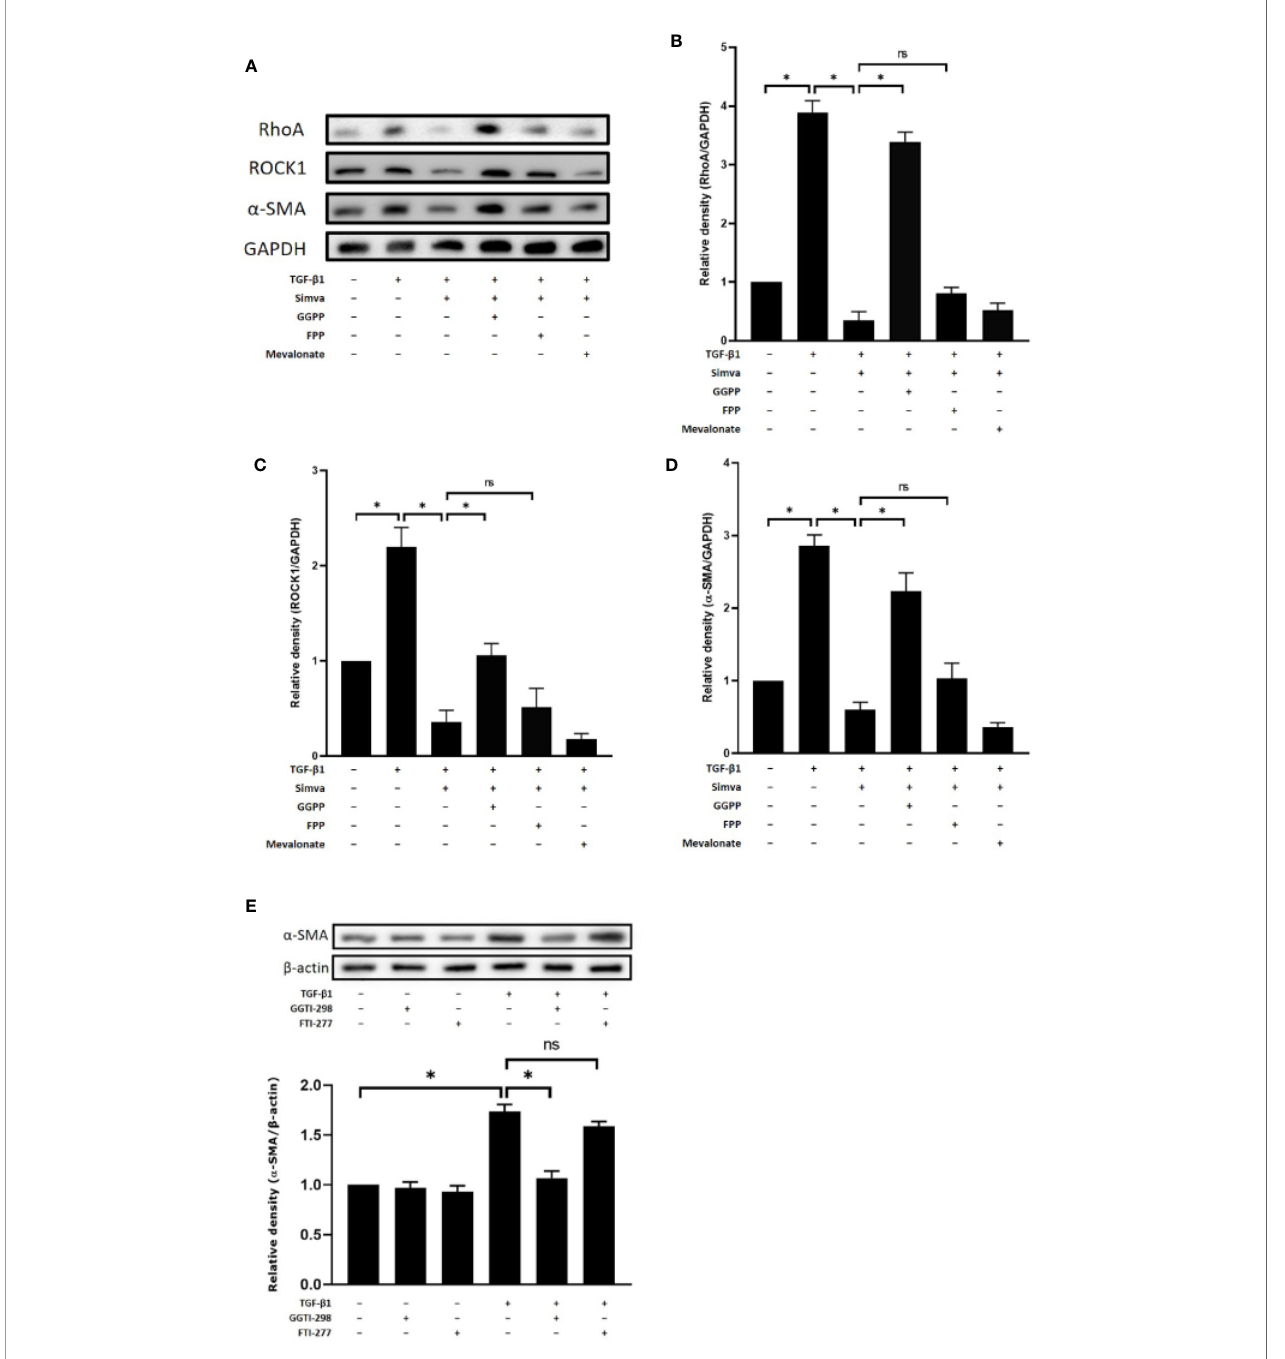
FIGURE 3 | Effects of hydroxymethylglutaryl-coenzyme A (HMG-CoA) downstream intermediates on simvastatin-mediated inhibition of transforming growth factor- b (TGF- b )-induced RhoA, Rho-associated protein kinase 1 (ROCK1), and a -smooth muscle actin ( a -SMA) expression. (A) Graves ’ ophthalmopathy (GO) orbital fi broblasts were stimulated with TGF- b 1 (3 ng/mL) for 48 h with or without a 1-h pretreatment with simvastatin (10 m M) and addition of geranylgeranyl pyrophosphate (GGPP) (10 m M), farnesyl pyrophosphate (FPP) (10 m M), or mevalonate (200 m M). The protein levels of RhoA, ROCK1, and a -SMA were determined using western blot analysis. (B – D) The densities of RhoA (B) , ROCK1 (C) , and a -SMA (D) protein bands were quanti fi ed and normalized to GAPDH. (E) GO orbital fi broblasts were stimulated with TGF- b 1 (3 ng/mL) for 48 h with or without a 1-h pretreatment with geranylgeranyl transferase inhibitor (GGTI-298) (10 m M) or farnesyl transferase inhibitor (FTI-227) (10 m M). The a -SMA protein production was determined using western blot analysis. Data are presented as mean ± SD of at least three independent experiments. *p <